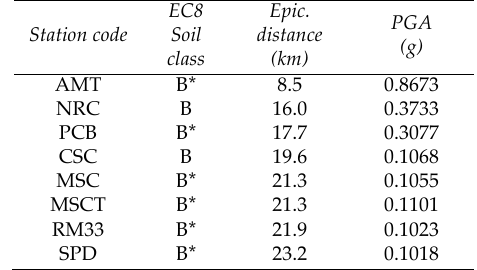
Table 1: Data of the accelerometric stations considered in this study